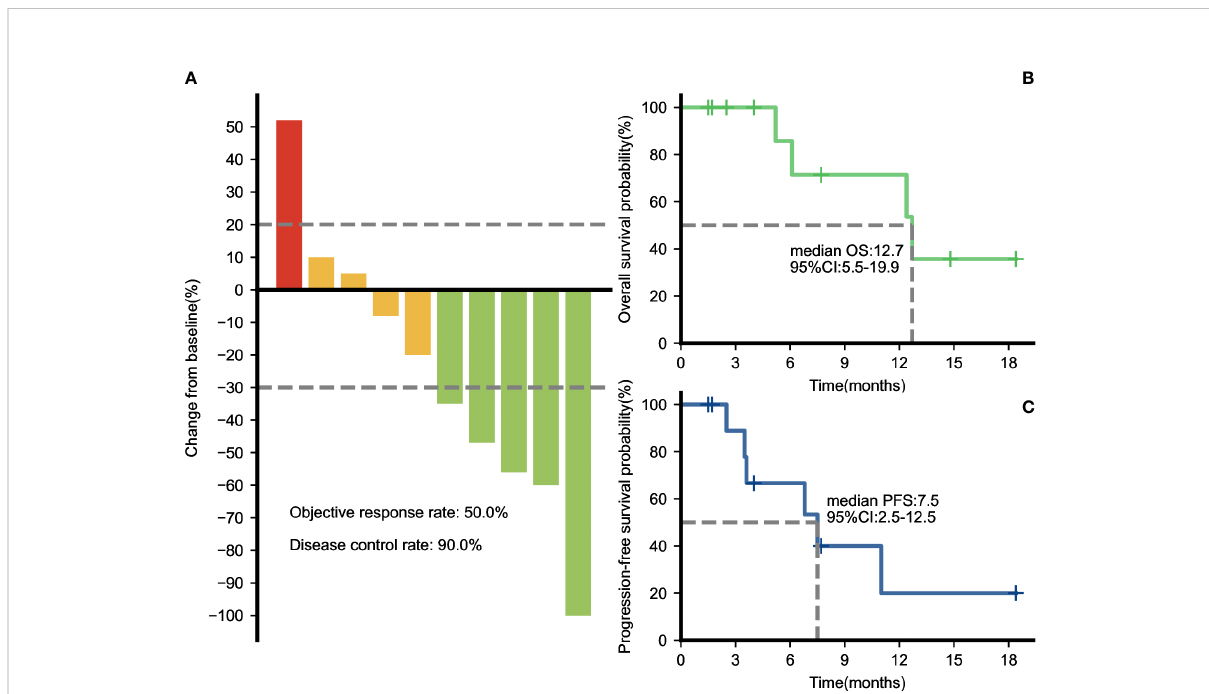
FIGURE 1 Therapeutic ef fi cacy of PD-1 inhibitors plus nab-paclitaxel-based chemotherapies. (A) Maximum percentage change in the sum of the diameters of the target lesions from baseline. The overall survival (B) and progression-free survival (C) curves of the entire cohort.